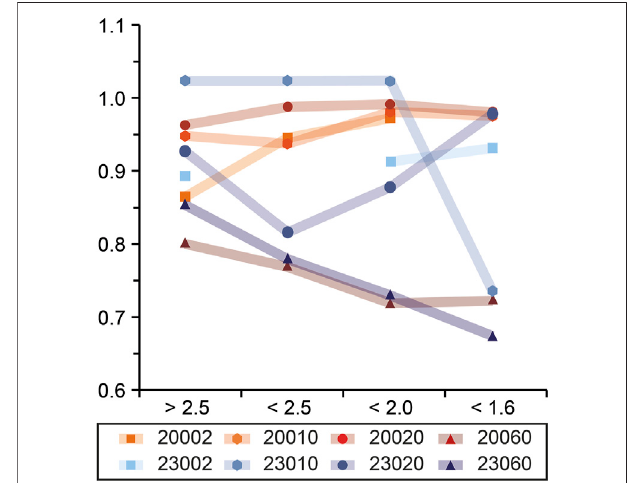
FIGURE 4 | F 14 C values in density fractions, coloured according to distance from shore (nm), symbol type according to shore-perpendicular transect. Density fraction-speci fi c radiocarbon data from the Namibian Shelf reveals older organic carbon in southern and offshore stations (23060), whereas inshore stations tend to be modern (e.g., 20002 &